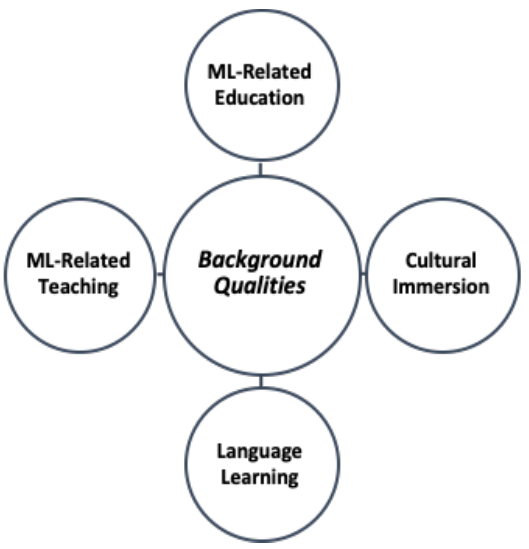
Figure 1: Background Qualities, as adapted from Lucas & Grinberg